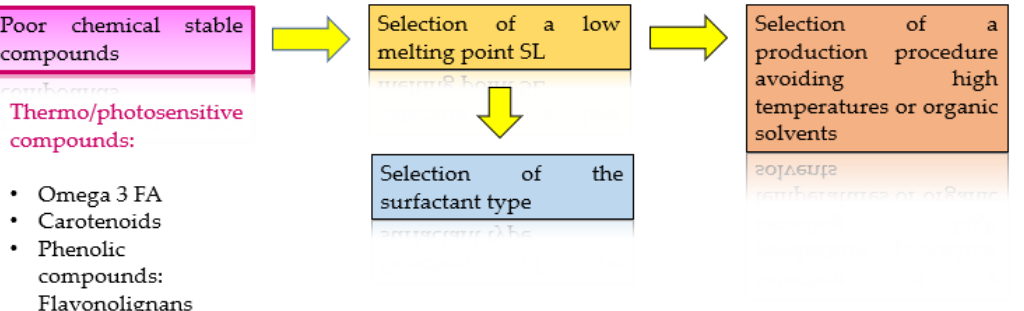
Figure 1. Diagram representing the key points to consider in nanoparticle formulation for loading unstable bioactive compounds.